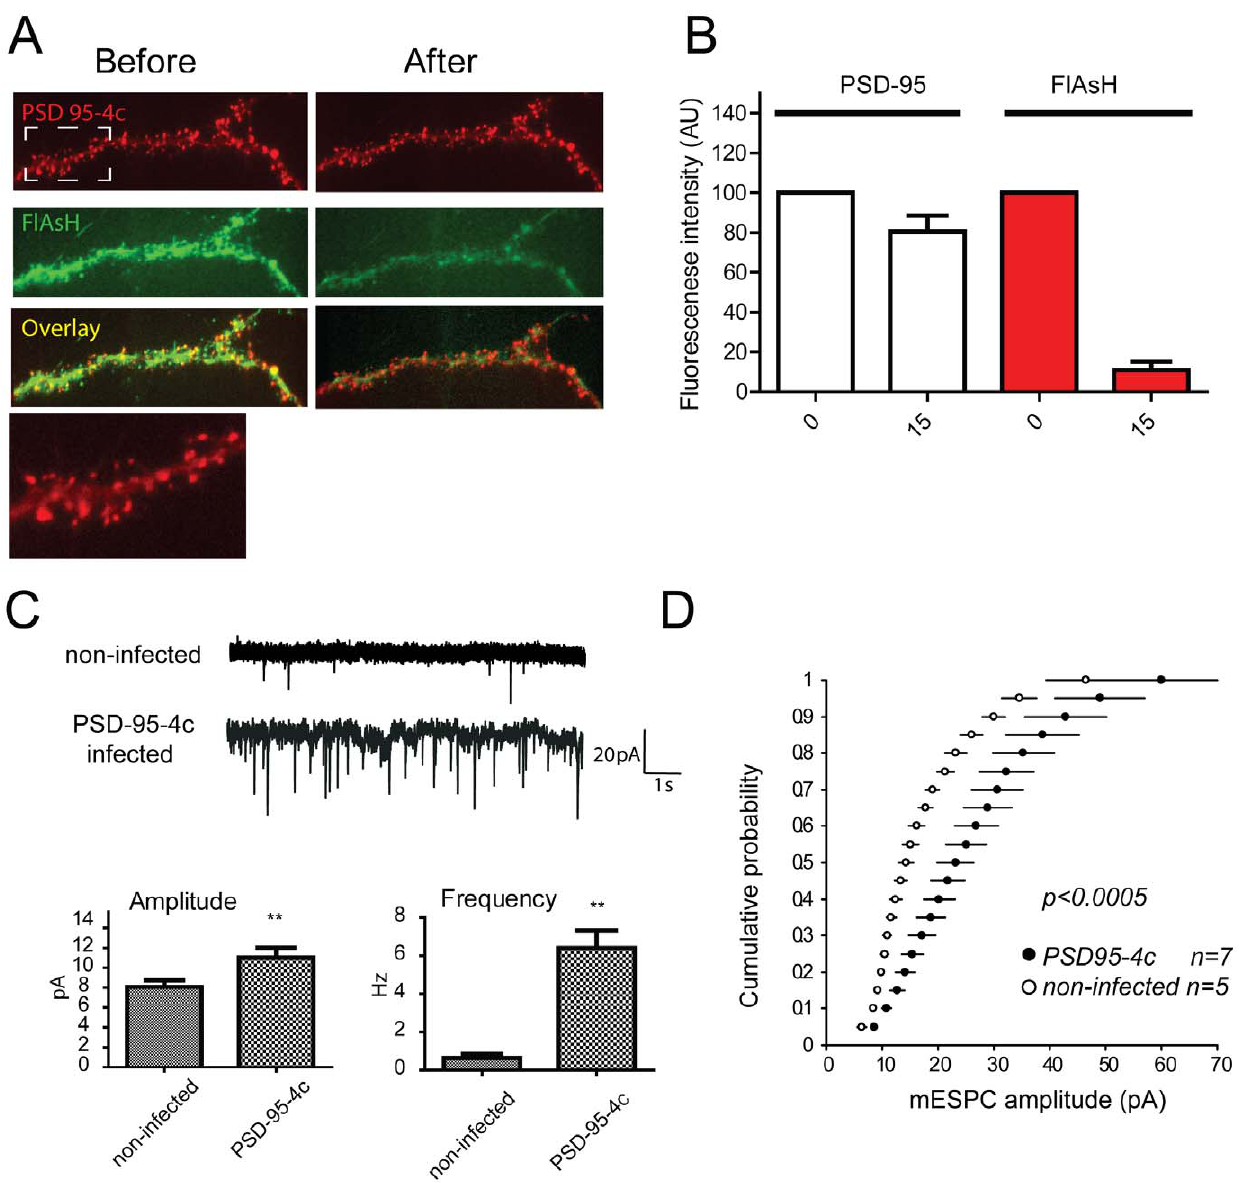
Figure 2. PSD-95-4c localizes at synaptic spines and increases EPSCs. Dissociated hippocampal neurons DIV 21 , 25 were infected with a Semliki forest virus for over-expression of PSD-95-4c. (A) PSD-95-4c localized to synaptic spines much like wt-PSD-95. Incubation with FlAsH shows localization of the fluorescein derivative at PSD-95-4c enriched spines. (B) PSD-95-4c and FlAsH fluorescence were quantified before and after FALI. (C) Whole-cell recordings were measured 16–24 hours after infection. PSD-95-4c significantly increased the amplitude and frequency of AMPA receptor- mediated mEPSCs compared to control indicating functional PSD-95-4c construct by the recruitment of additional AMPA receptors to synapses. (D) Cumulative probability distribution of mEPSC amplitude from control and PSD-95-4c infected